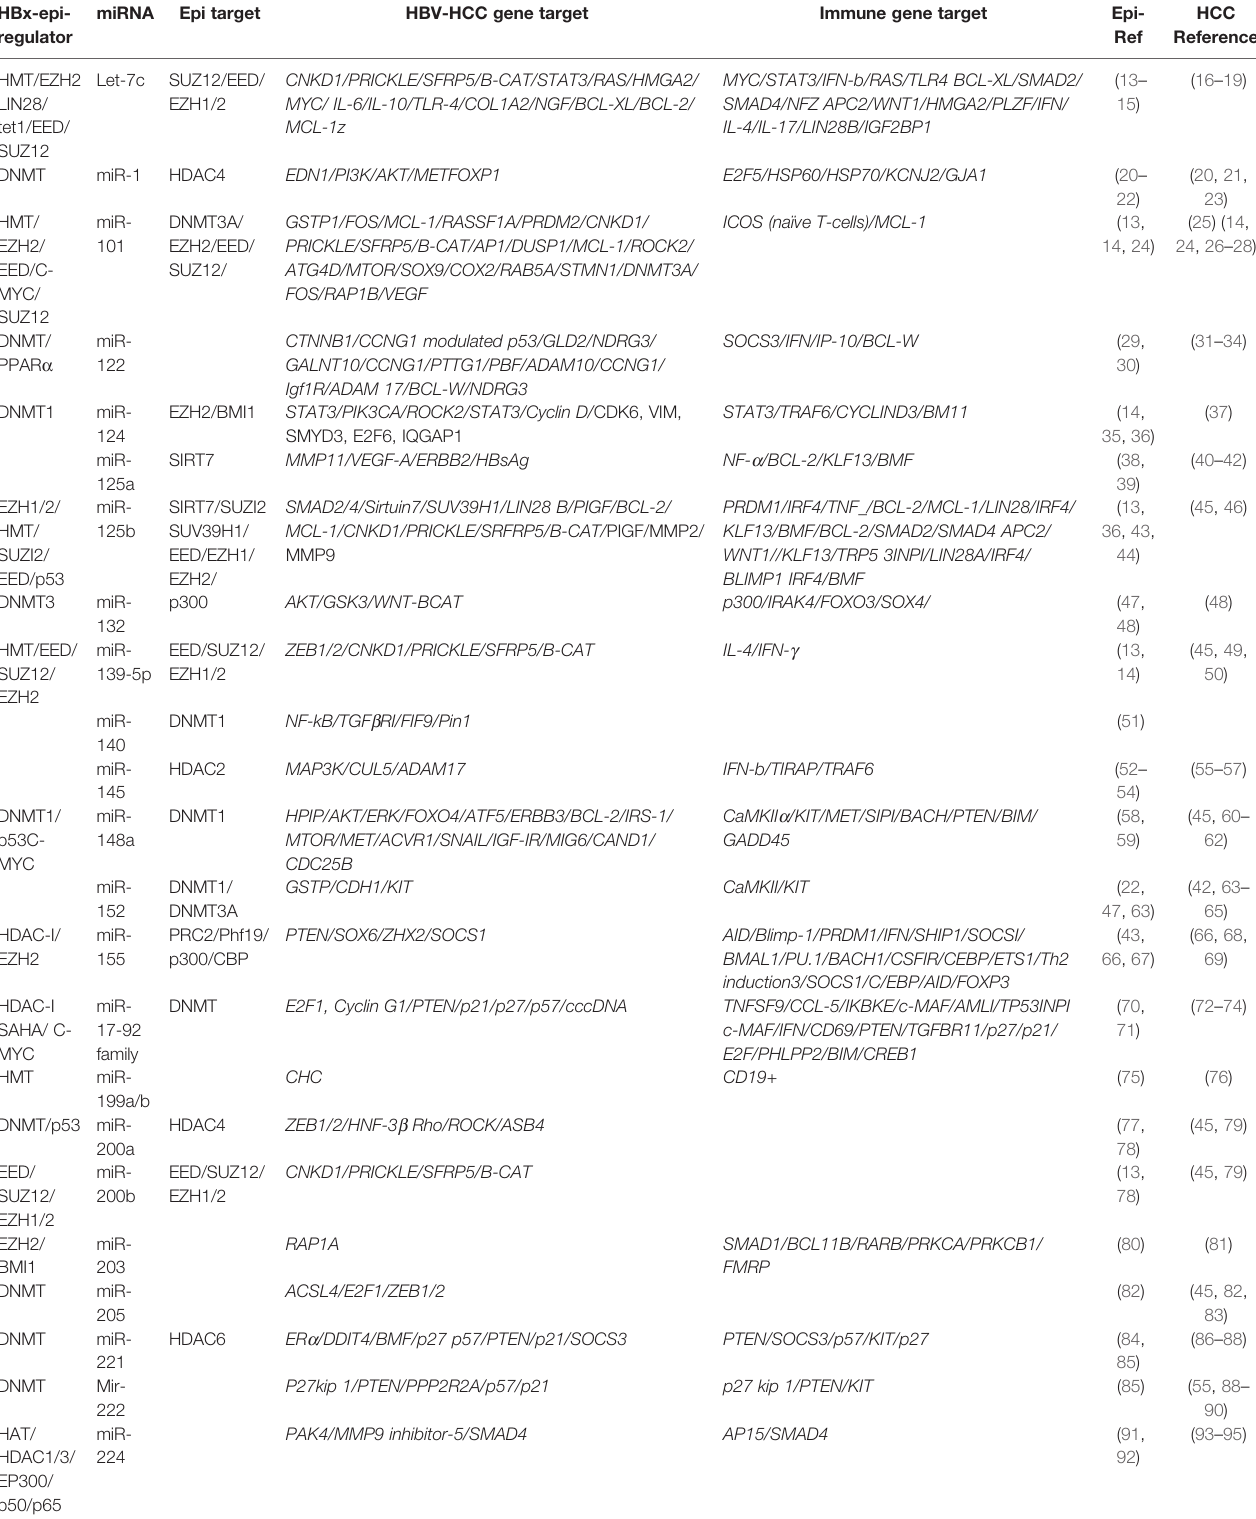
TABLE 1 | HBx-dysregulated epi-miRNA and their targets in HBV-HCC. HBx-epi- regulator